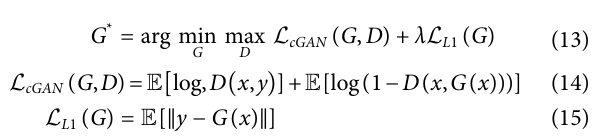
Frontiers in Arti fi cial Intelligence |